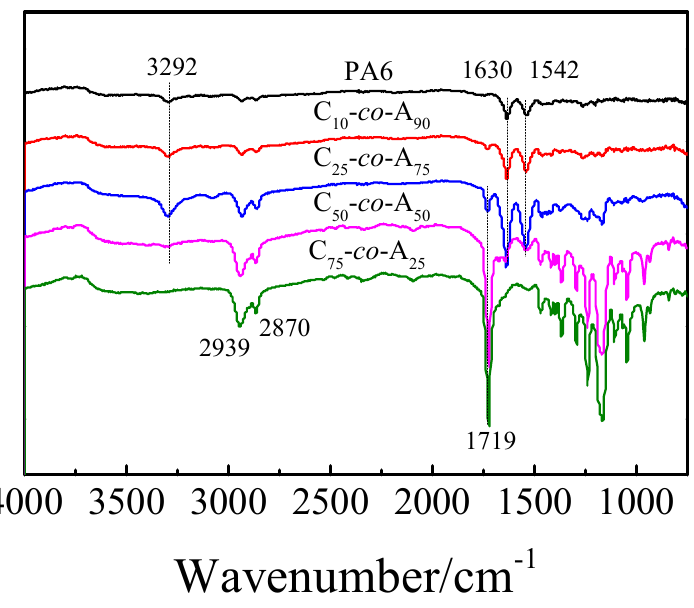
Figure 3. FTIR spectra of P(CLA- co -CLO) copolymers.